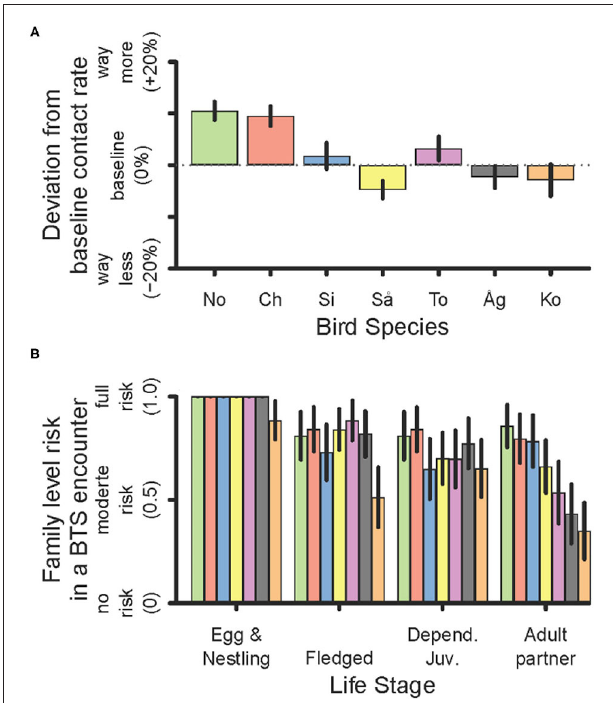
FIGURE 1 | Risk of being encountered by BTS. (A) Deviation in risk of encounter by a BTS for each bird species from a baseline BTS contact rate in an environment. Summary of expert rankings and translation to numeric deviation in parentheses. Species are ordered along the x-axis by increasing body size (No, Nosa ' ; Ch, Chichirika; Si, Sihek; Så, Såli; To, Totot; Åg, Åga; Ko, Ko ' ko ' ). (B) The risk ranking (probability) that each member of a family with a parent encountered by a BTS is also encountered by this BTS. Error bars delineate the 95% confidence